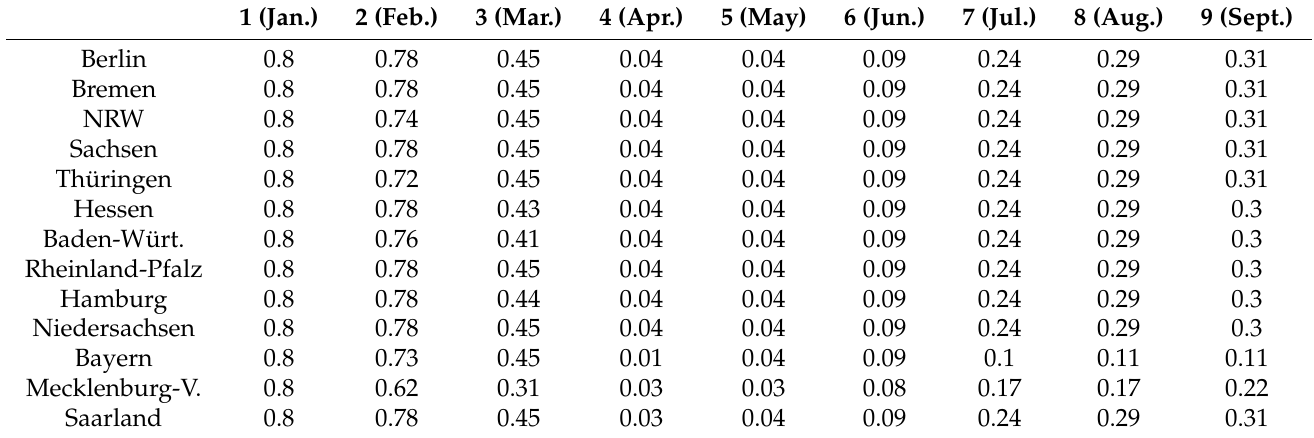
Table 1. Value of the indicator per month and state as shown in Figure